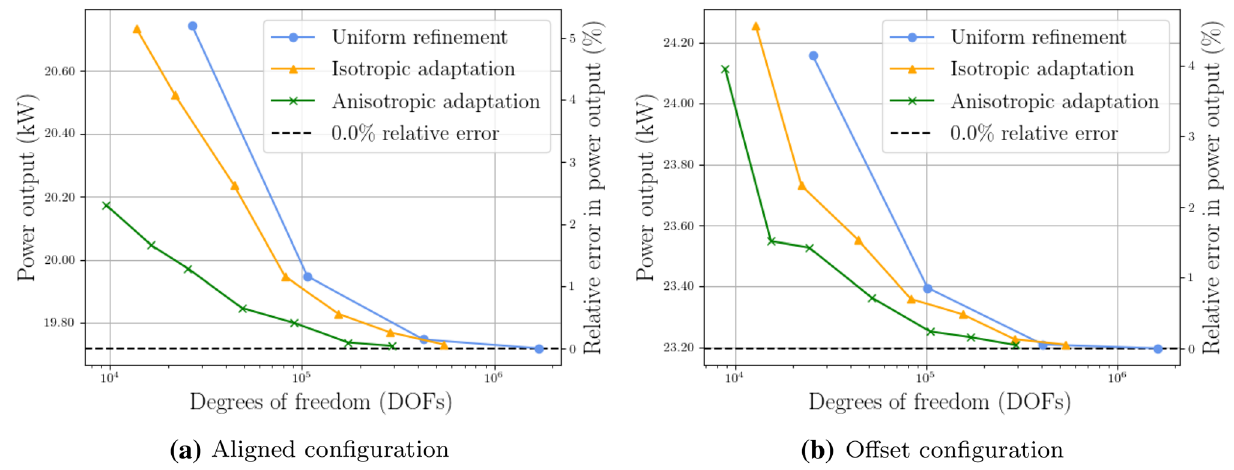
Fig. 4 QoI convergence analysis under uniform refinement, isotropic adaptation and anisotropic adaptation for the a aligned and b offset array